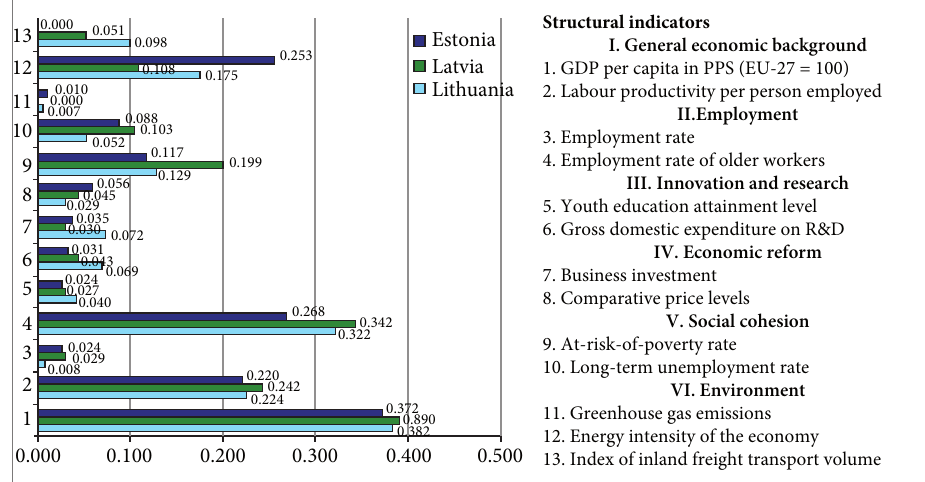
Fig. 6. Deviations of Baltic States’ structural indicators values from maxima in the European Union (Reference Point approach),